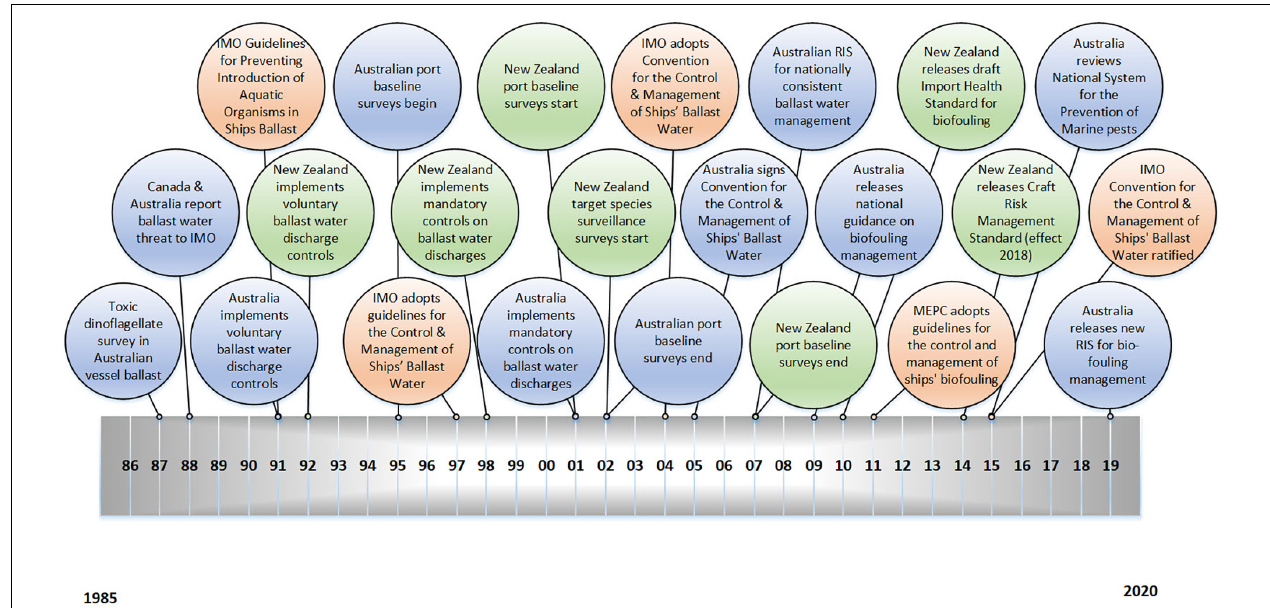
FIGURE 1 | Timeline of major international (orange), Australian (blue) and New Zealand (green) management actions associated with marine pest introductions by ballast water and hull fouling, from 1985 to the present